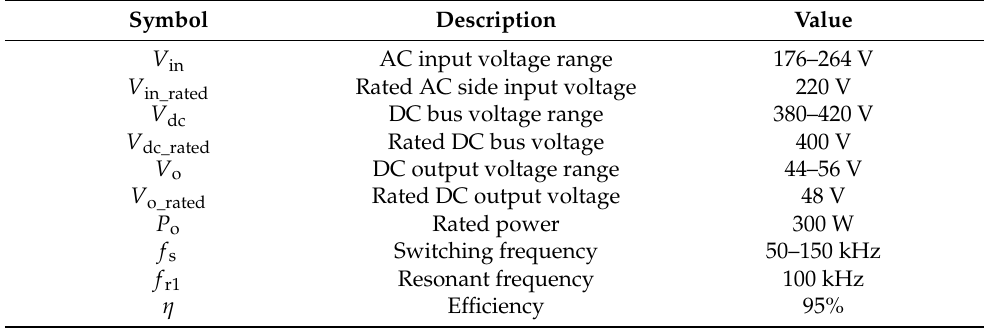
Table 1. Design of the charging